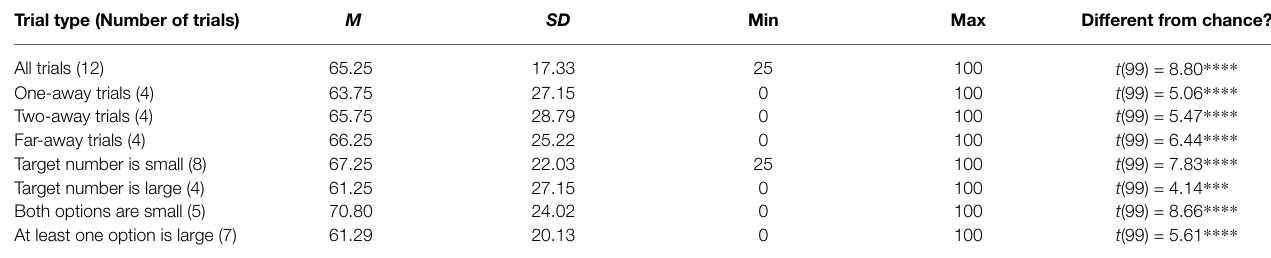
TABLE 2 | Descriptive statistics for children’s performance in the Point-to-X task, N = 100. Trial type (Number of trials) M